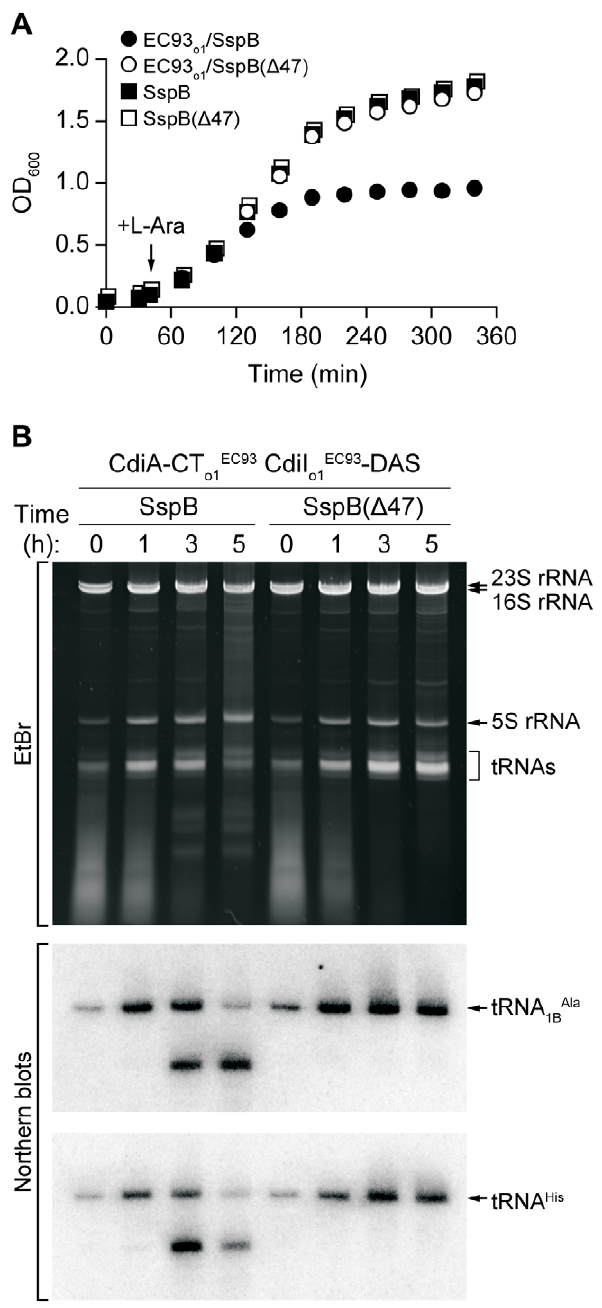
Figure 5. CdiA-CT o1EC93 inhibits the growth of E.coli cells. A) Growth curves of E. coli D sspB cells expressing CdiA-CT o1EC93 /CdiI o1EC93 - DAS. Degradation of CdiI o1EC93 -DAS was initiated by the addition of L- arabinose to induce SspB synthesis. Control cells express SspB( D 47), which does not deliver CdiI o1EC93 -DAS to the ClpXP protease. Growth curves with square symbols represent control strains expressing SspB or SspB( D 47), but not CdiA-CT o1EC93 /CdiI o1EC93 -DAS. B) Analysis of in vivo CdiA-CT o1 EC93 tRNase activity. Total RNA was isolated from cells expressing CdiA-CT o1 EC93 /CdiI o1 EC93 -DAS at varying times after L- arabinose induction. Samples were run on polyacrylamide gels followed by staining with ethidium bromide (EtBr) or Northern blot analysis using probes specific for tRNA 1BAla and tRNA His .